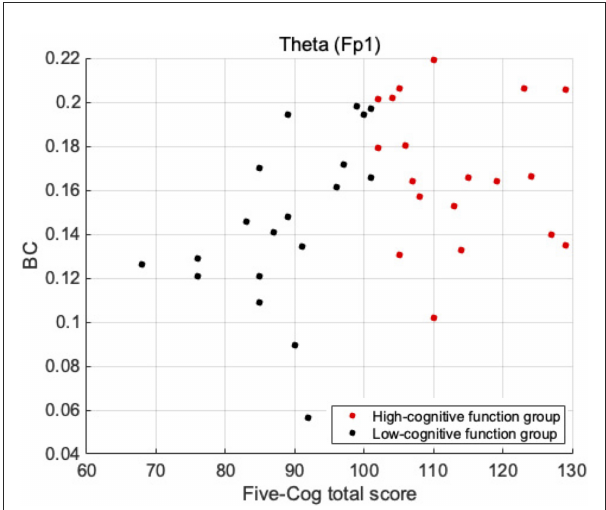
FIGURE2 Scatter plot between BC values and Five-Cog total scores at Fp1 in the theta band, which exhibited significant large β for Five-Cog total score in Table 4. The result showed the different tendency of BC distribution between high- and low-cognitive function groups.